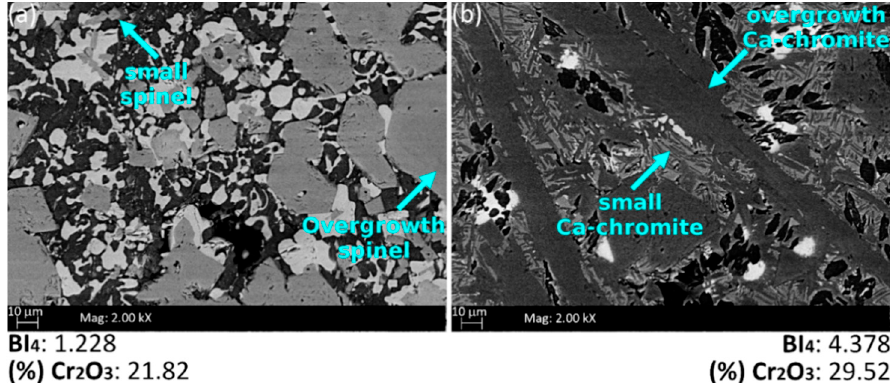
Figure 7. Examples of slag samples where overgrowth Cr-bearing phases coexist with small ones. ( a ) sample #19 ( b ) sample #8.